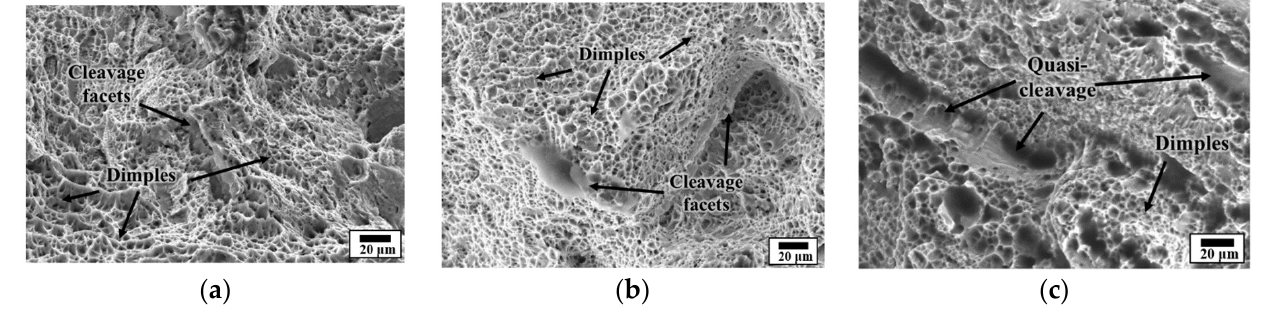
Figure 12. Fracture behaviour of deposited specimen for different energy density (J/mm 3 ): ( a ) Energy density 155 J/ mm 3 ; ( b ) Energy density 118 J/mm 3 ; and ( c ) Energy density 68 J/mm 3 .